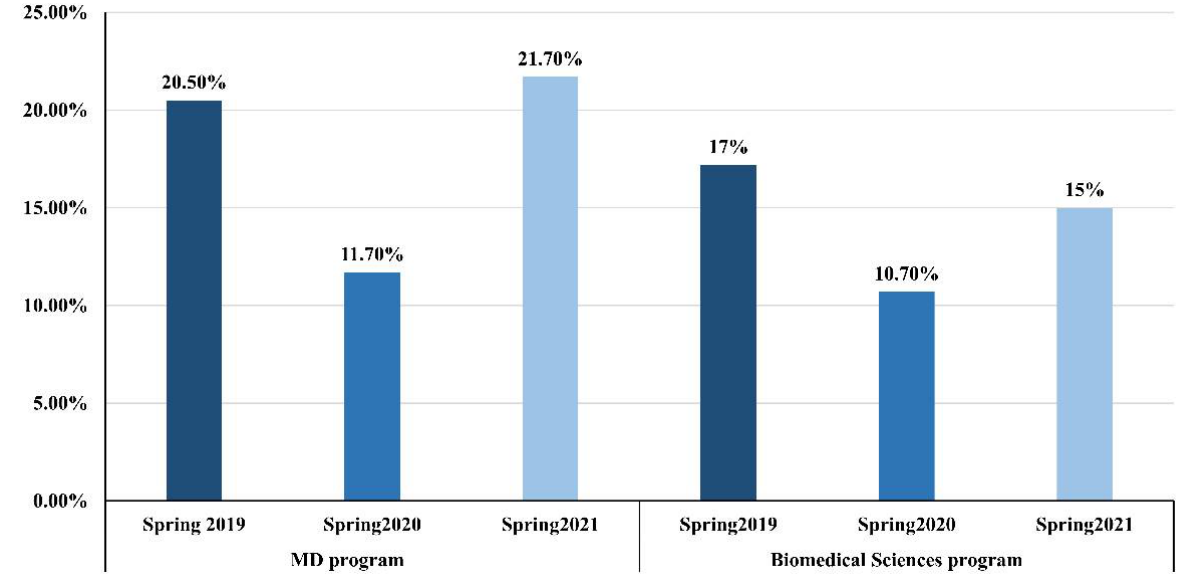
Figure 2. The co-efficient of variance calculated for the students’ scores in the practical component of basic anatomy courses for MD and biomedical sciences programs in three semesters. CV = SD/Mean × 100.